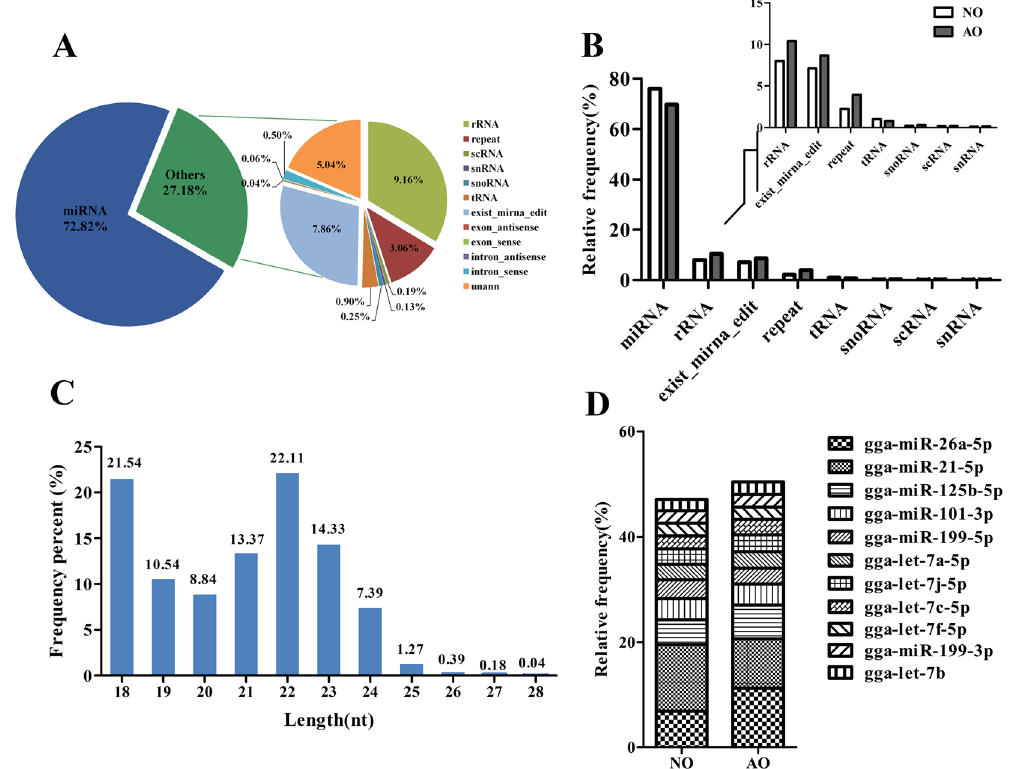
Figure 5. Overview of small RNA sequencing in the chicken ovary. ( A ) Portions of small RNA types in the clean reads. The percent of miRNA is approximately 73%, and the other 28% included rRNA, scRNA, snRNA, snoRNA, tRNA, simple repeats, exon sense/antisense and intron sense/antisense. ( B ) Relative frequency of different types of small RNAs in the atrophic ovary (AO) and normal ovary (NO). ( C ) Size distribution of all miRNAs. The X-axis depicts their length (nt), and the Y-axis represents frequency (%). ( D ) The relative proportion of the top 10 miRNAs in the total amount of